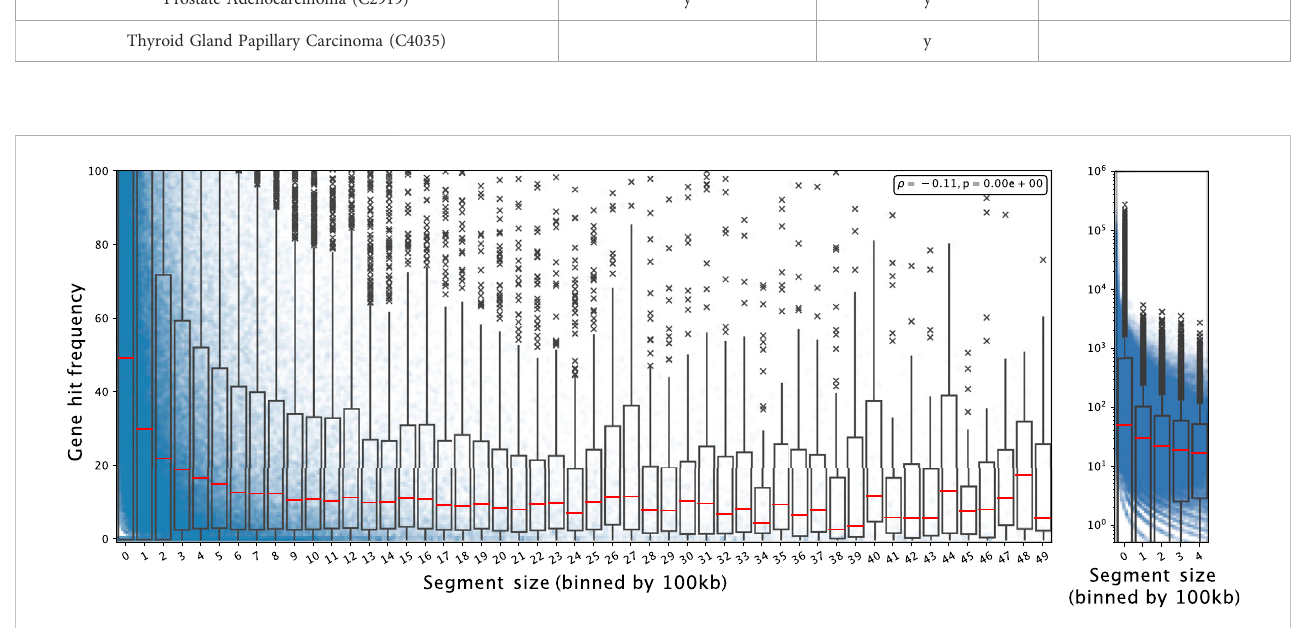
FIGURE 1 Gene hit frequency decreases as CND segment size increases Each dot shows an individual gene deletion event in a segment falling into the bin size range and the boxplot shows thesummarystatistics of thebinincluding its25, 50(red line; median), 75percentiles. Left: The segment size is shown from 0to 5MB; thegene hitfrequency islimitedup to100 atalinear scale to show thedecaywith thebins.Right:for segment size between 0and500 kbwithlog scale on y